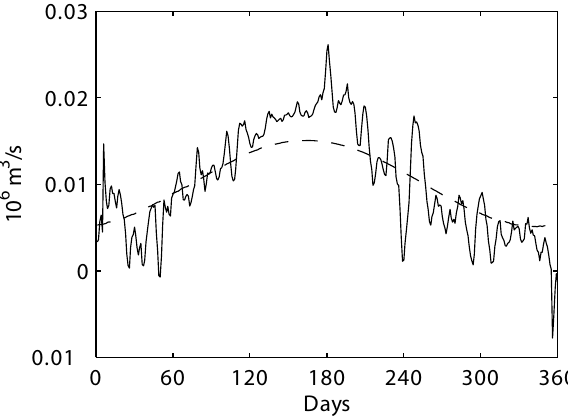
Fig. 7. Net volume transport time series at ALERMO’s open bound- ary (continuous line) and volume discharge into the Aegean Sea due to the Dardanelles and river runoff (dashed line). Positive values of volume transport denote ouflow from the model domain. Units are 106m 3